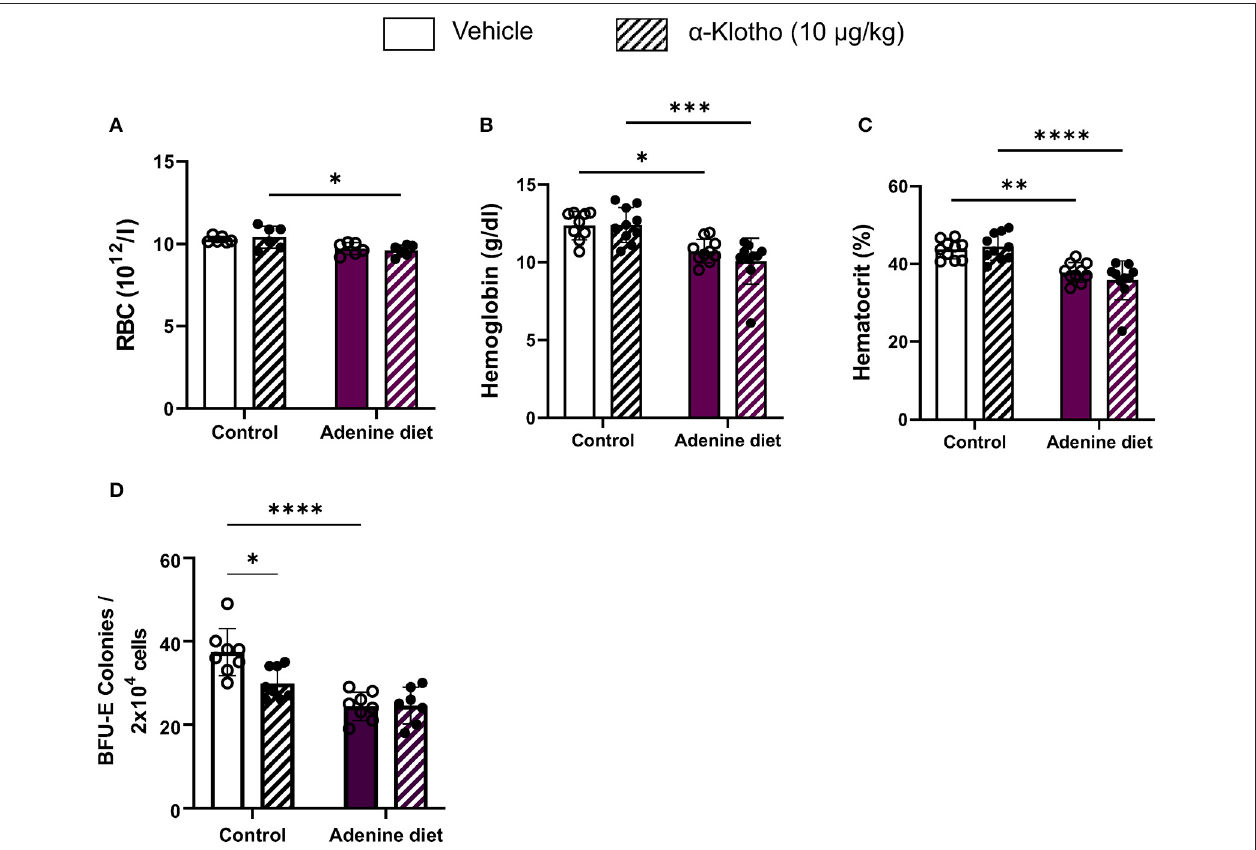
FIGURE 2 | Effect of adenine diet and Klotho administration on circulating red blood cell parameters and bone marrow erythroid progenitor cells. (A–C) Whole blood was collected and analyzed by complete blood count for circulating red blood cell parameters. (A) Red Blood Cells (RBCs), (B) Hemoglobin (Hgb), (C) Hematocrit (Hct). (D) Femoral and tibial bone marrow cells were isolated and cultured for 12 days on methyl cellulose medium and counted for erythroid progenitor cells, burst forming unit erythroid (BFU-E). Data are represented as mean ± SD ( n = 7–10 per group). * P < 0.05, ** P < 0.01, *** P < 0.001, **** P < 0.0001 compared to